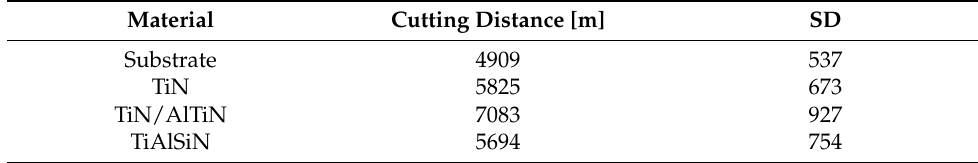
Table 4. Durability test results of substrate, TiN/AlTiN, TiN and TiAlSiN